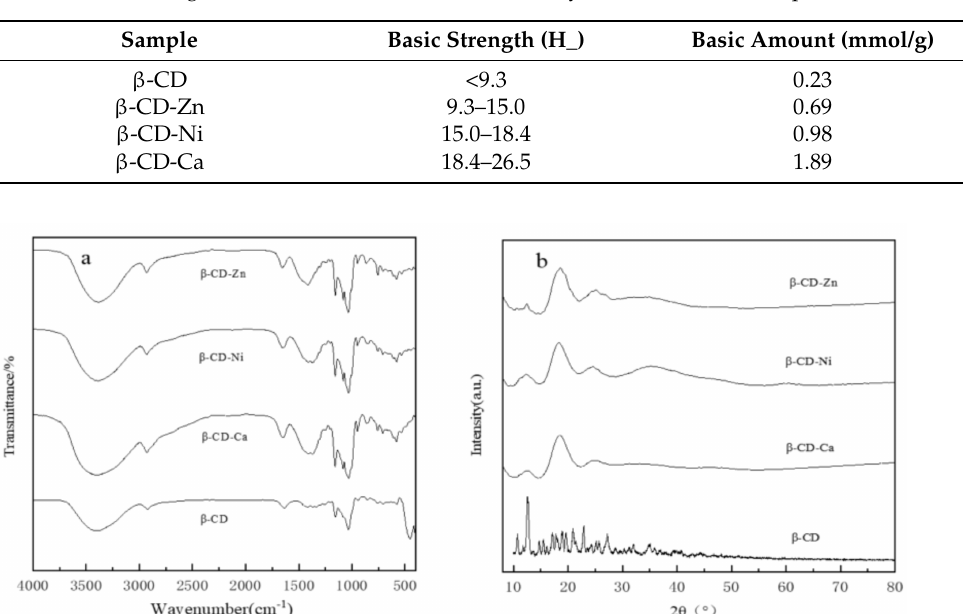
Table 1. Basic strength and basic amount of β -CD and β -cyclodextrin-metal complexes.